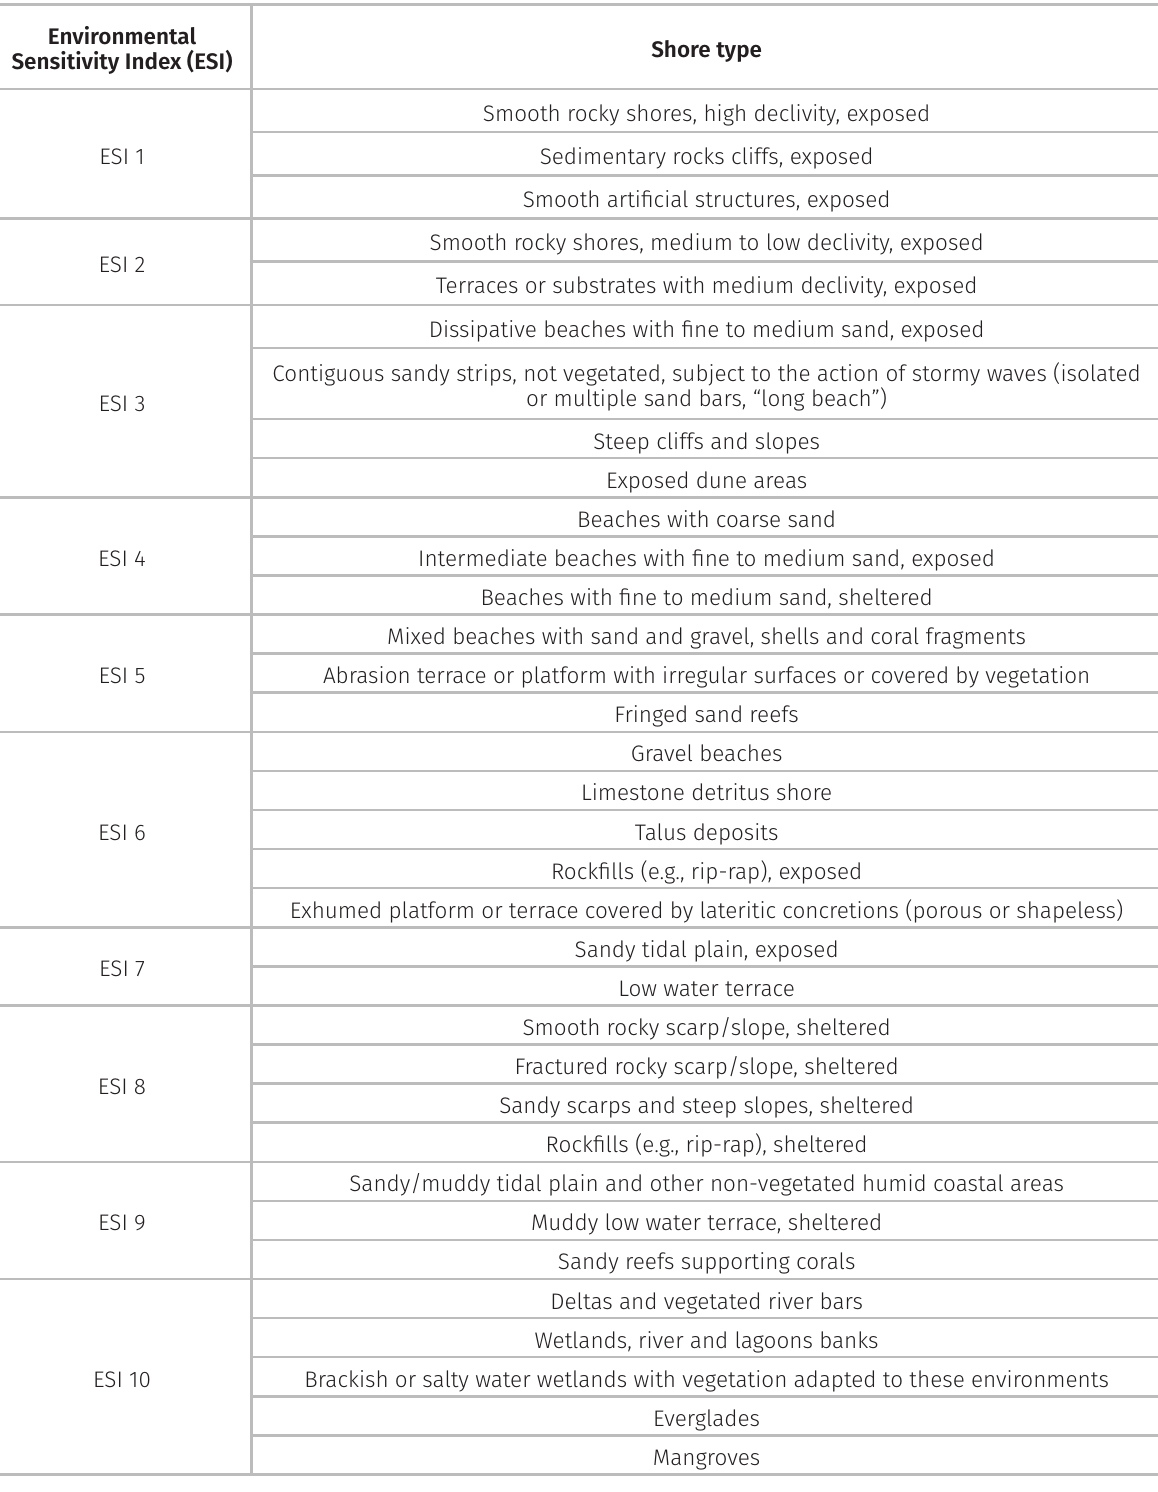
Table II. Environmental Sensitivity Index (ESI) classes following the guidelines proposed by the Brazilian Ministry of the Environment (“Ministério do Meio Ambiente - MMA”; MMA,